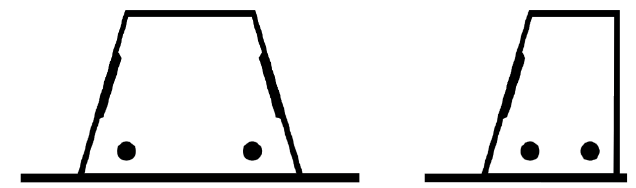
Figure 8. Double- and single-sided delta beam cross-sections.